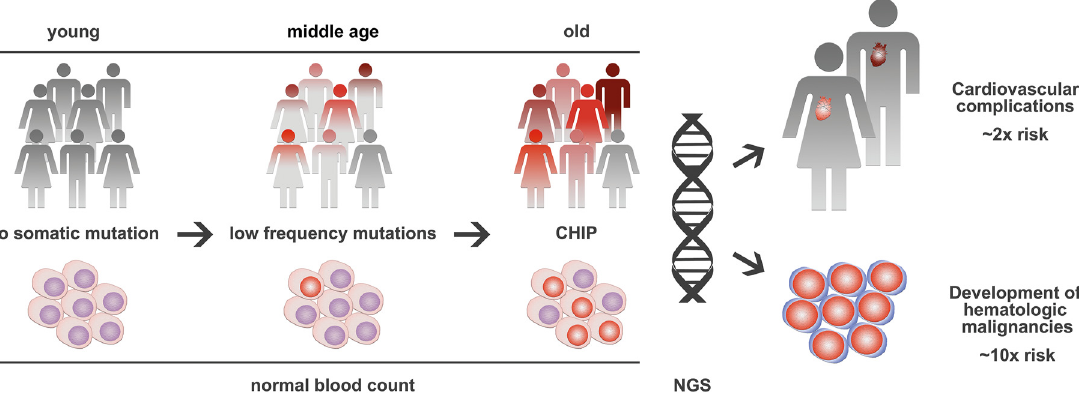
Figure 1: Clonal hematopoiesis of indeterminate potential (CHIP) is a hematopoietic precursor lesion with an increased risk of progression to mostly myeloid hematopoietic neoplasms and associated with cardiovascular and other non-hematopoietic diseases. Genetic analysis of a gene panel by next generation sequencing (NGS) is necessary to diagnose and monitor CHIP. Figure modified from Hoermann et al.